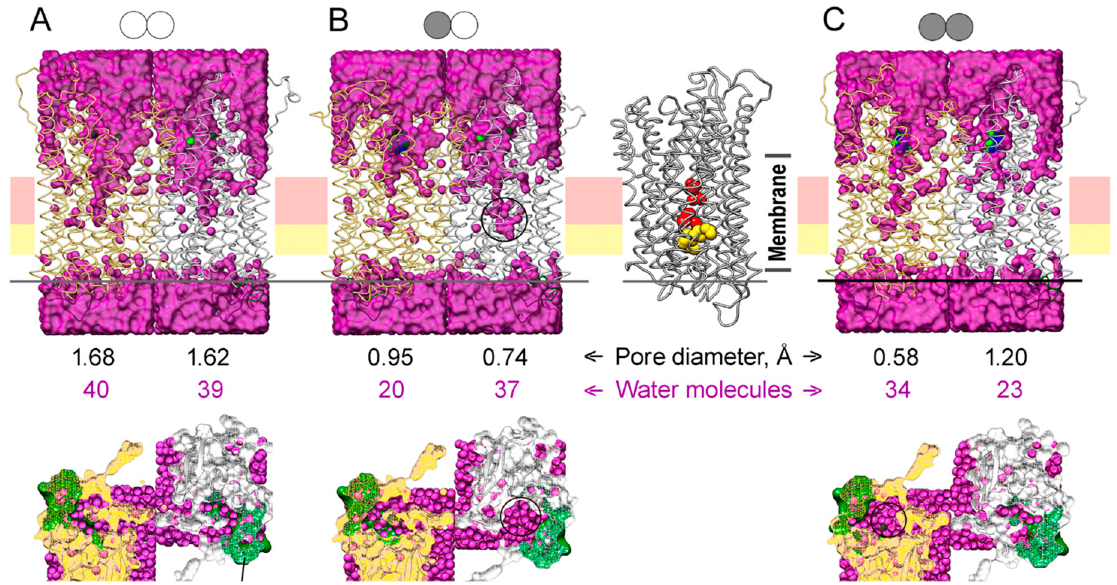
Figure 9. The water content of the MD-simulated structures of the IDP complexes of Vr-mPPase of different stoichiometry in a membrane/aqueous environment: ( A ) the IDP-free enzyme; ( B ) the enzyme with one IDP-bound subunit; ( C ) the fully IDP-bound enzyme. The top panels show the view along the membrane plane. Water oxygens are magenta circles, and two Vr-mPPase subunits are depicted in a ribbon mode in gold and grey colors. The schemes above indicate a dimer binding state; IDP-free and IDP-bound subunits are shown, respectively, by open and closed circles. The bottom panels present the top view of the exit channel cross-section, whose position is indicated by the horizontal line on the top panels. The black circles on the three panels mark the regions with enriched water content compared to the IDP-free dimer. The right part of panel B shows the IDP-bound subunit with the residues forming the ionic channel (Arg242, Asp294, Lys742, and Glu301; red) and the hydrophobic gate (Leu232, Ala305, Leu555, and Val746; yellow) in a space-filling representation. The positions of these elements on the upper panels are indicated by horizontal pink and yellow stripes. The two rows of numbers between the top and bottom panels show the minimal pore diameter of the ion-conducting channel at the hydrophobic gate and the combined number of the water molecule in the ionic channel and the hydrophobic gate.